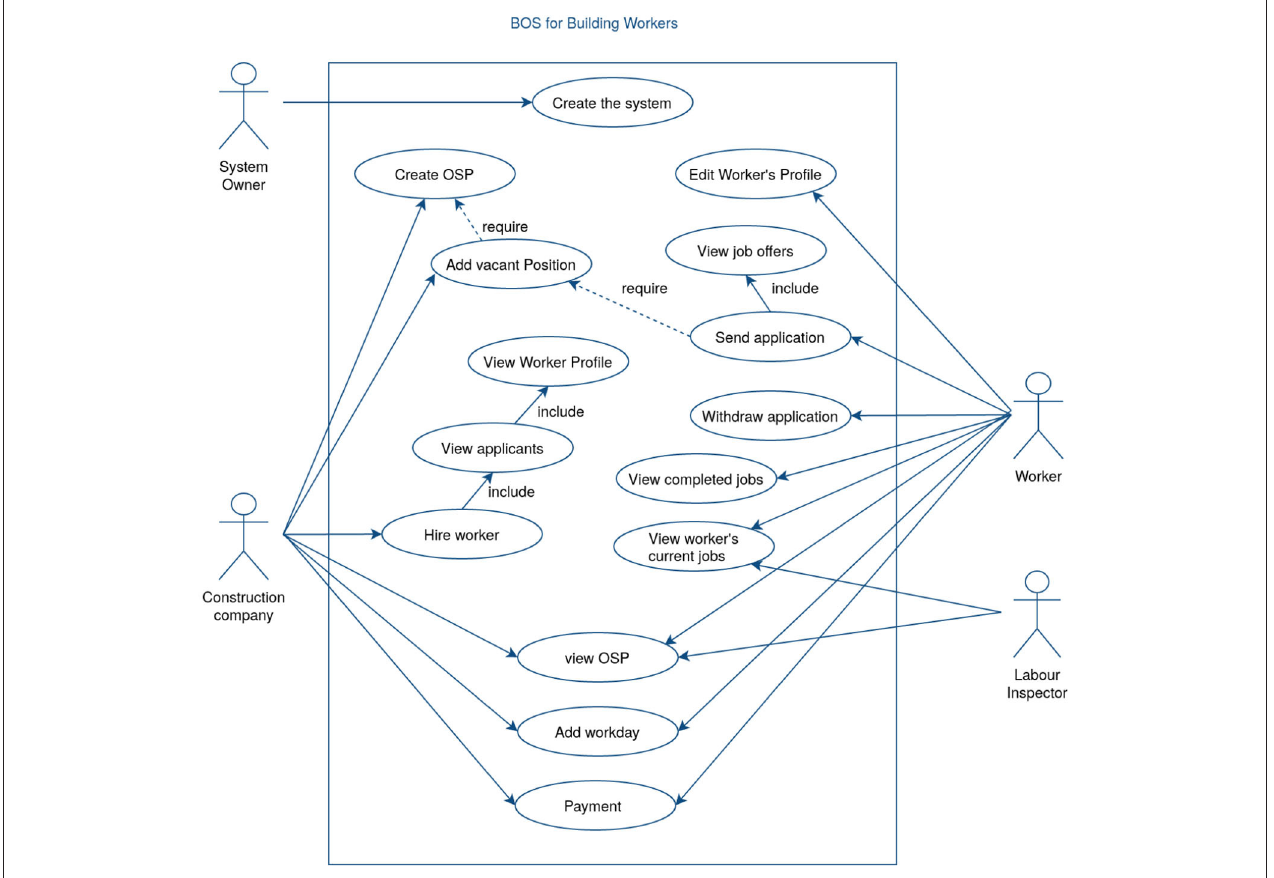
FIGURE 2 | The UML Use Case diagram of the BOS system which represents system actors and system